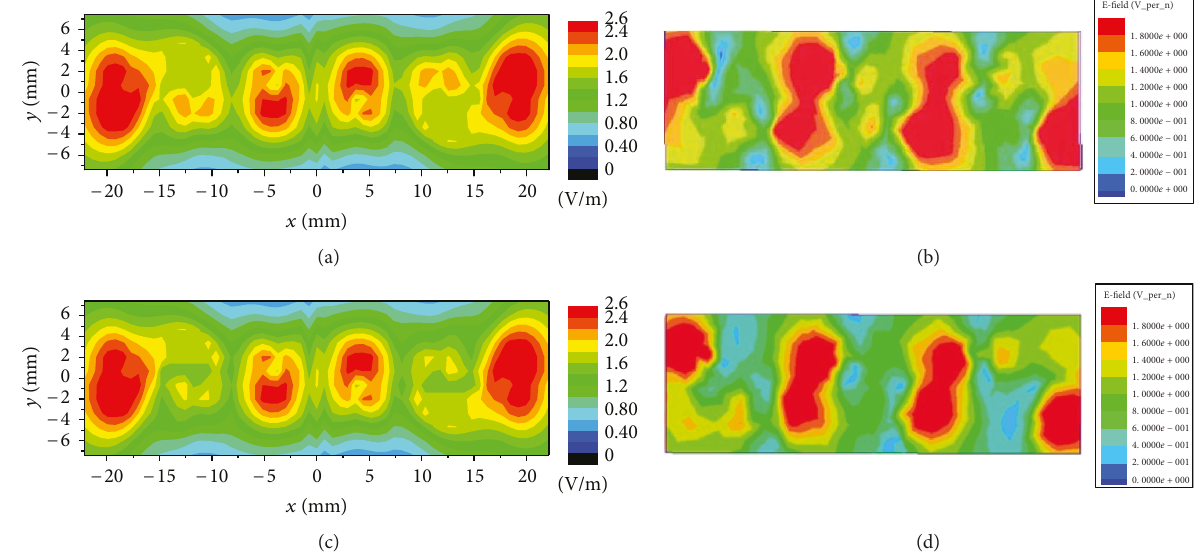
Figure 5: Lattice B: results received (a) and (c) theoretically and (b) and (d) via simulation. The absolute value of the electric fi eld intensity on planes inside the host and 2mm o ff from (a) and (b) the “ front side ” on which the x -polarized plane wave impinges perpendicularly and (c) and (d) the “ back side ” of the slab. Amplitude of the plane wave E 0 = 1 V/m and f = 2 035GHz